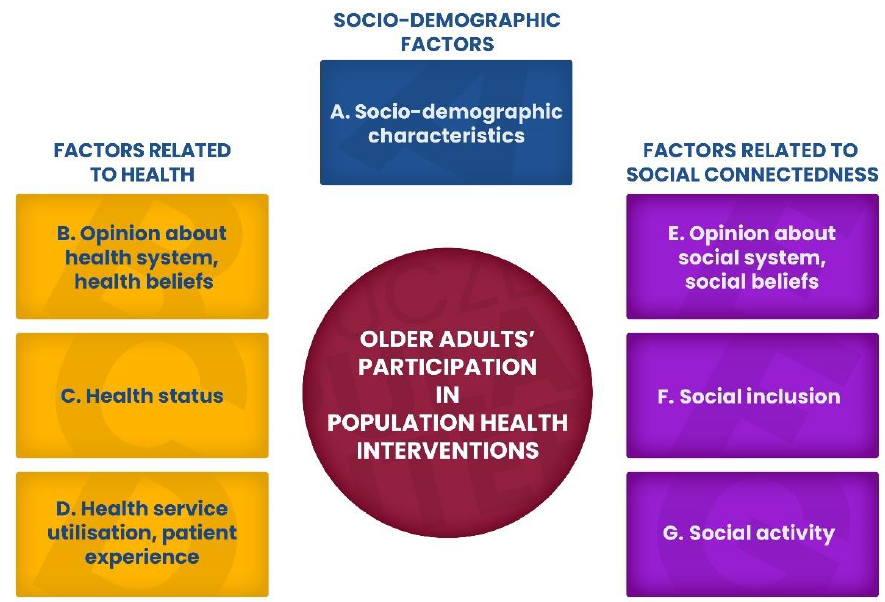
Figure 1. Conceptual framework of the study.